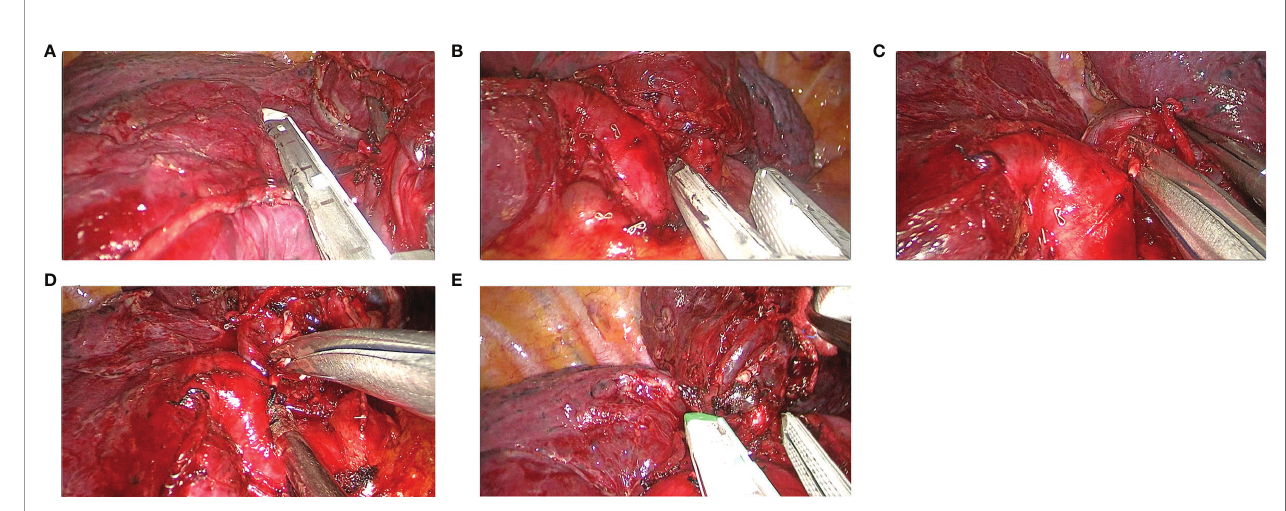
FIGURE 2 | The main steps of the VAB procedure. (A) Stapling the upper vein, (B) stapling the upper arterial branches, (C) cutting the variant arterial branches, (D) cutting the posterior ascending artery, and (E) stapling the upper